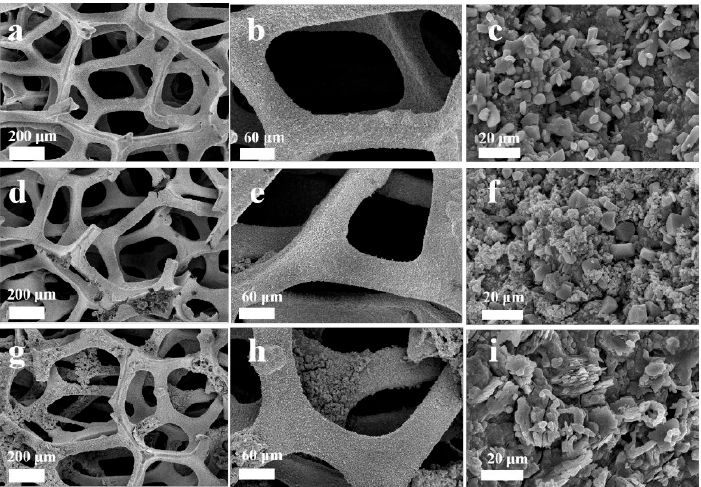
Figure 14. SEM images of Fe ‐ CdIn 2 O 4 on nickel foam. ( a – c ) 25%; ( d – f ) 30%; and ( g – i ) 35% [130].